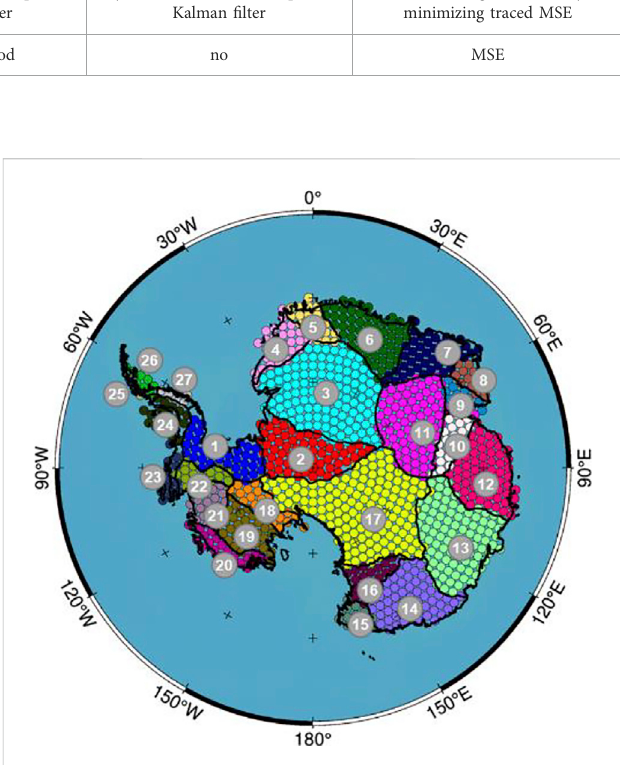
FIGURE 2 Regional distribution of basins (numbers 1 – 27) based on the de fi nition of Zwally et al. (2012) and the distribution of mascon points covering